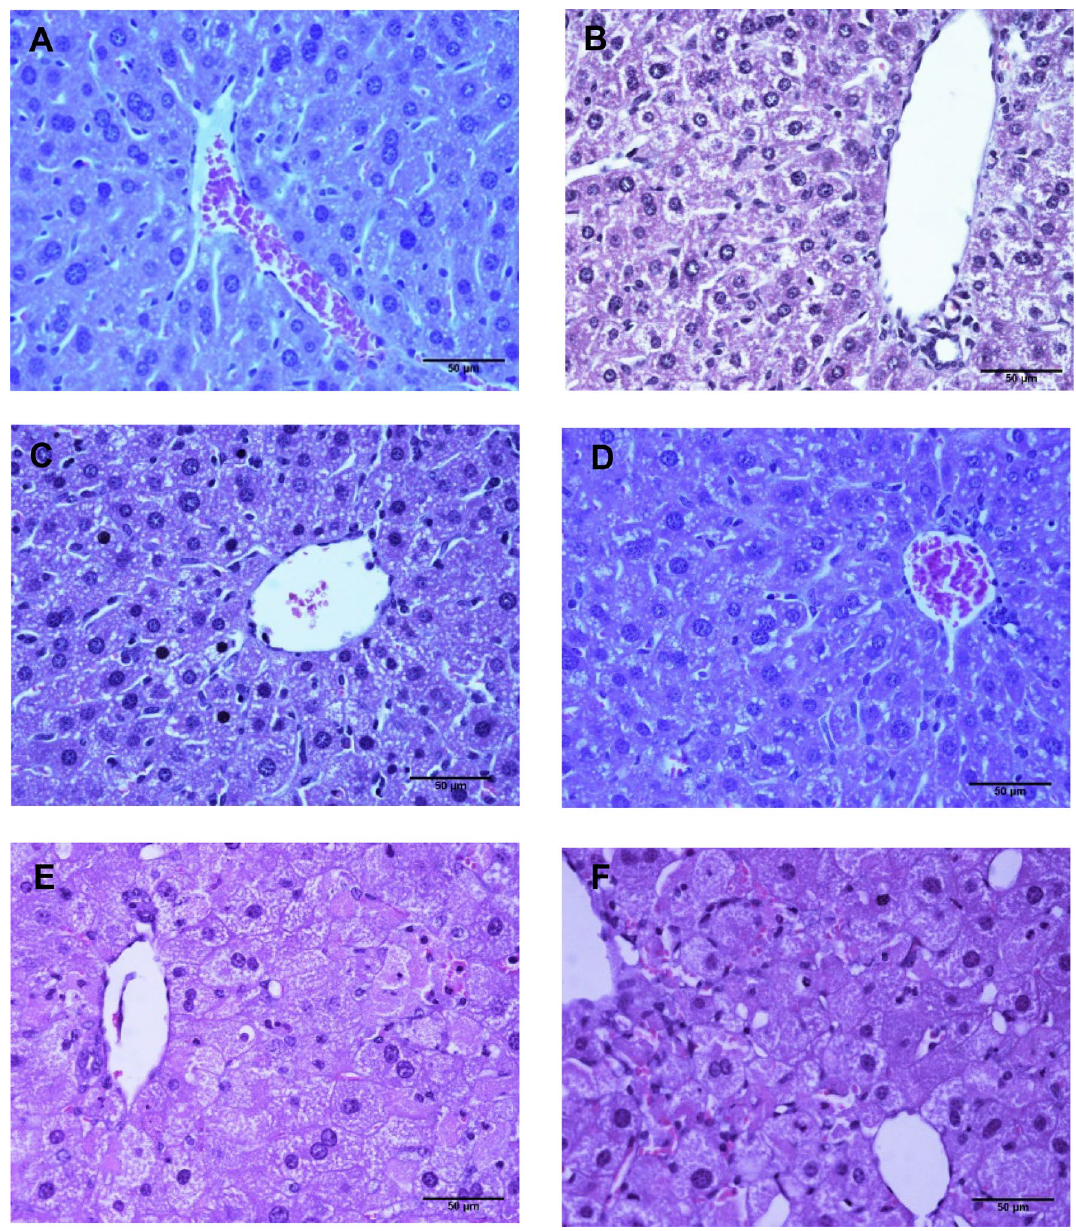
Figure 2. Microscopy images of liver tissue from mice after cholesterol-rich diet and rosuvastatin. Mice liver slices were stained with hematoxylin–eosin. ( A ) CD; ( B ) CD + Ro; ( C ) HD; ( D ) HD + Ro one day; ( E ) HD + Ro 3 days; ( F ) HD + Ro 5 days. CD, control diet; HD, cholesterol-rich diet; Ro, rosuvastatin 20 mg/kg/day. The liver of CD + Ro 20 mg/kg/day obtained after 1, 3 and 5 days of treatment manifest early steatosis and significant changes in the cellular structure. Sinusoidal dilatation ( D–F ), some cells with ballooning degeneration, pyknotic nuclei ( E , F ), Mallory Denk bodies ( E ) and hepatocytes with loss of their nuclei ( E , F ) are